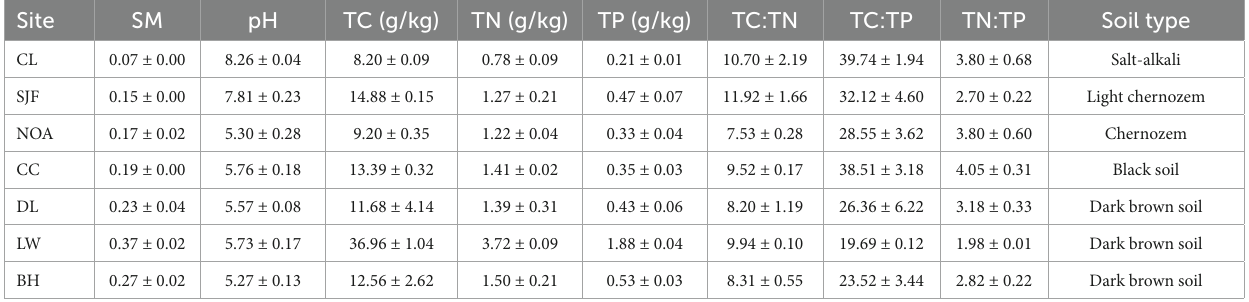
TABLE 2 Soil properties and their stoichiometry from 0 to 50 cm at each sampling